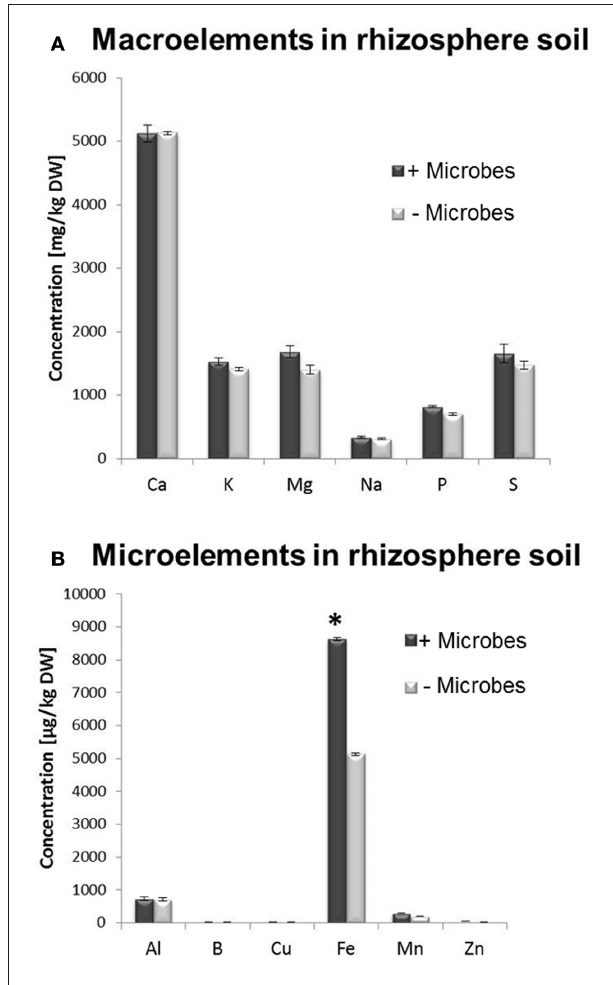
FIGURE 3 | ICP-OES analysis of total element concentration in sieved rhizosphere soil from Arabidopsis plants grown in the presence or absence of soil microbes. (A) Macronutrients, (B) Micronutrients. Bars present mean values in mg/kg of soil dry weight (DW) ± SE from 3 independent replicates (100g soil pooled from 10 pots/replicate). The asterisk indicates a statistically significant difference ( P < 0 . 05).